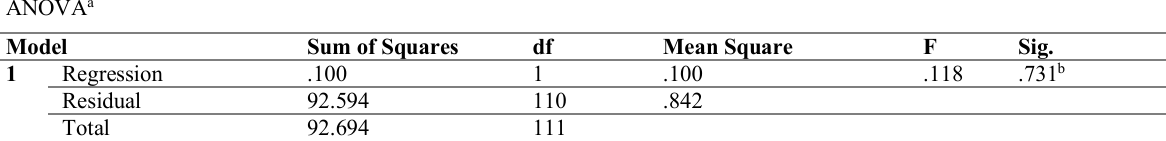
Table 4: Regression ANOVA for supportive leadership